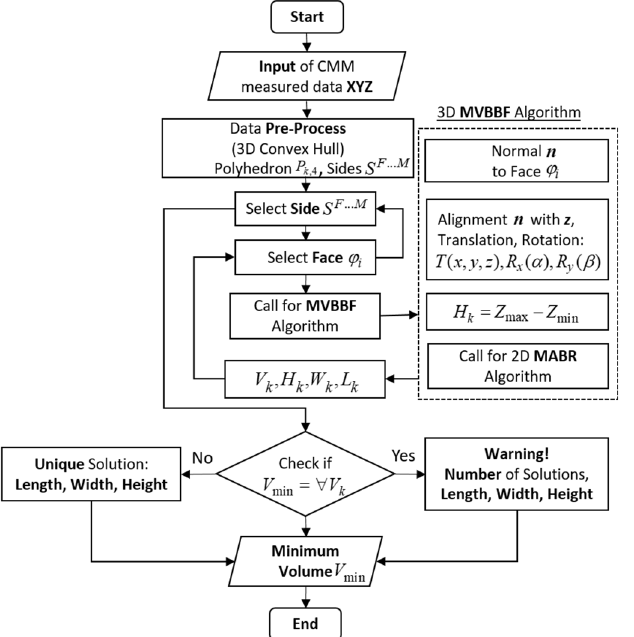
Fig. 7. The fl owchart of the MVBBF method.